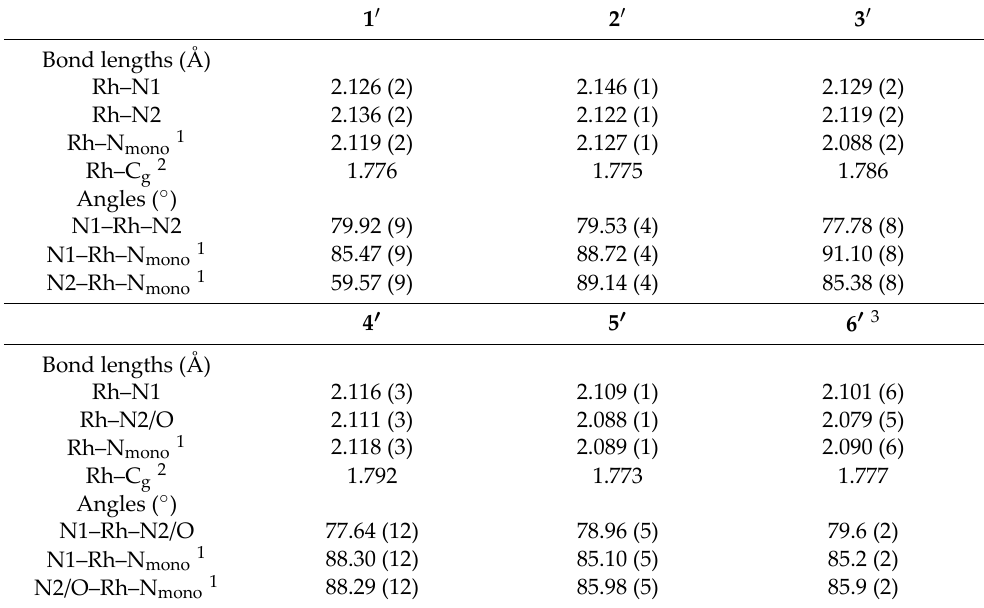
Figure 7. Molecular structure of ( a ) [RhCp*(en)(mim)](CF 3 SO 3 ) 2 ( 1 ′ ), ( b ) [RhCp*(en)(Py)](CF 3 SO 3 ) 2 ( 2 ′ ), ( c ) [RhCp*(phen)(mim)](BPh 4 ) 2 ×2 CH 2 Cl 2 ( 3 ′ ), ( d ) [RhCp*(phen)(Py)](CF 3 SO 3 ) 2 ×CH 3 OH ( 4 ′ ), ( e ) [RhCp*(8HQH − 1 )(mim)](BPh 4 )×CH 3 OH ( 5 ′ ), and ( f ) [RhCp*(8HQH ‐ 1 )(Py)](BPh 4 ) ( 6 ′ ). Solvent molecules and counter ions are omitted for clarity. Displacement ellipsoids are drawn at a 50% probability level. Table 2. Selected bond distances (Å) and angles (°) in complexes 1 ′ –6 ′ . Values in parenthesis are the standard deviations.